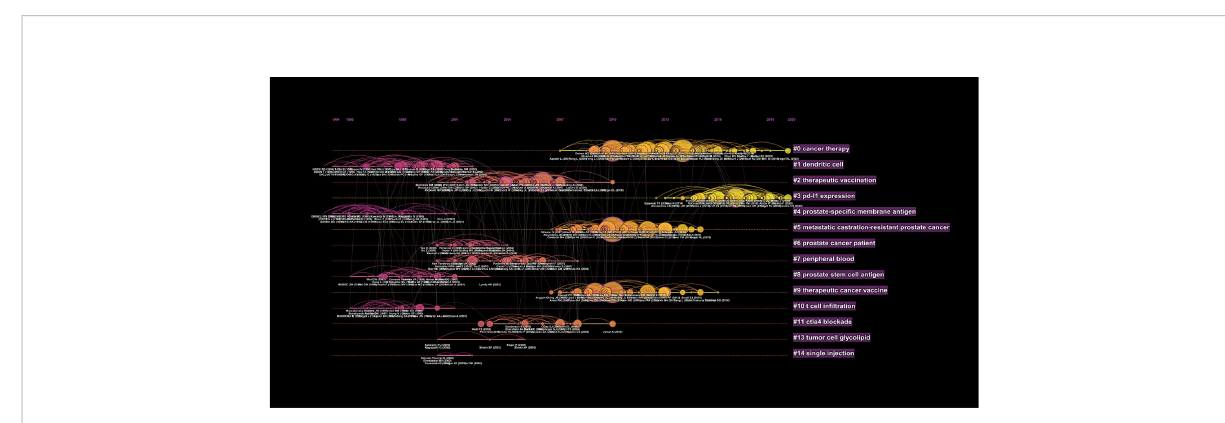
FIGURE 6 The timeline view of publications related to PCa immunotherapy with relevant clusters.